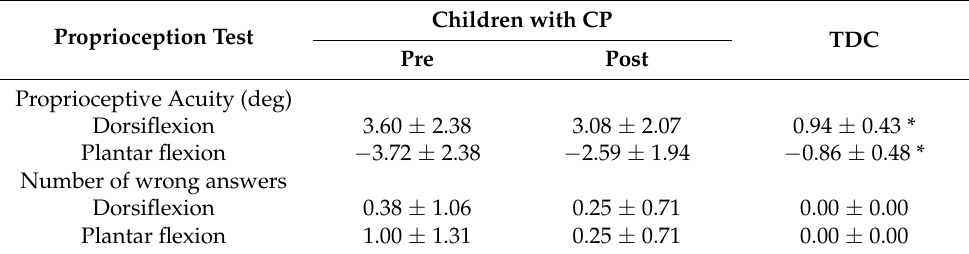
Table 2. Proprioceptive acuity among the children with CP and the typically developing children.